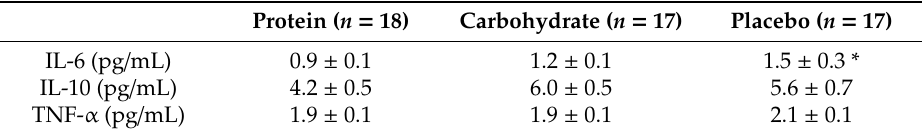
Table 2. Baseline cytokine